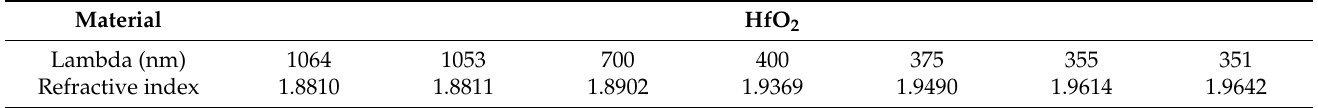
Table 2. Membrane material index for refraction at different